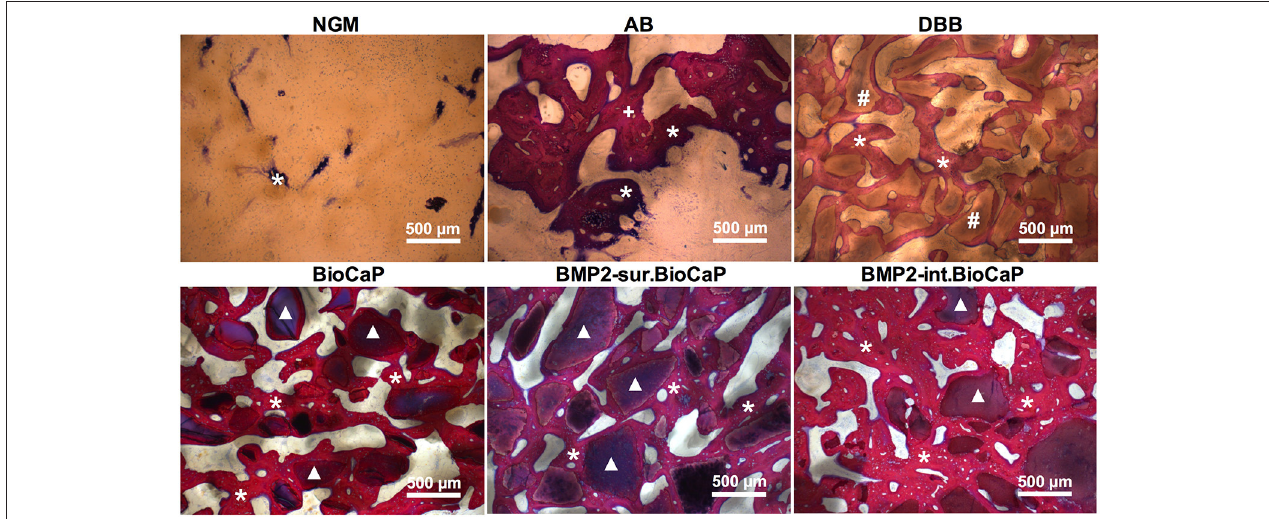
FIGURE 7 | Histological images in higher magnification showing newly formed bone and grafted biomaterials in the defect site after 8 weeks of grafting. White stars: newly formed bone; + : remaining autologous bone; #: remaining